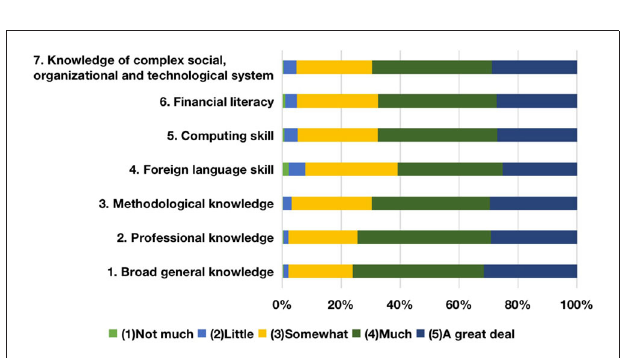
FIGURE 4 | Development of graduates’ basic